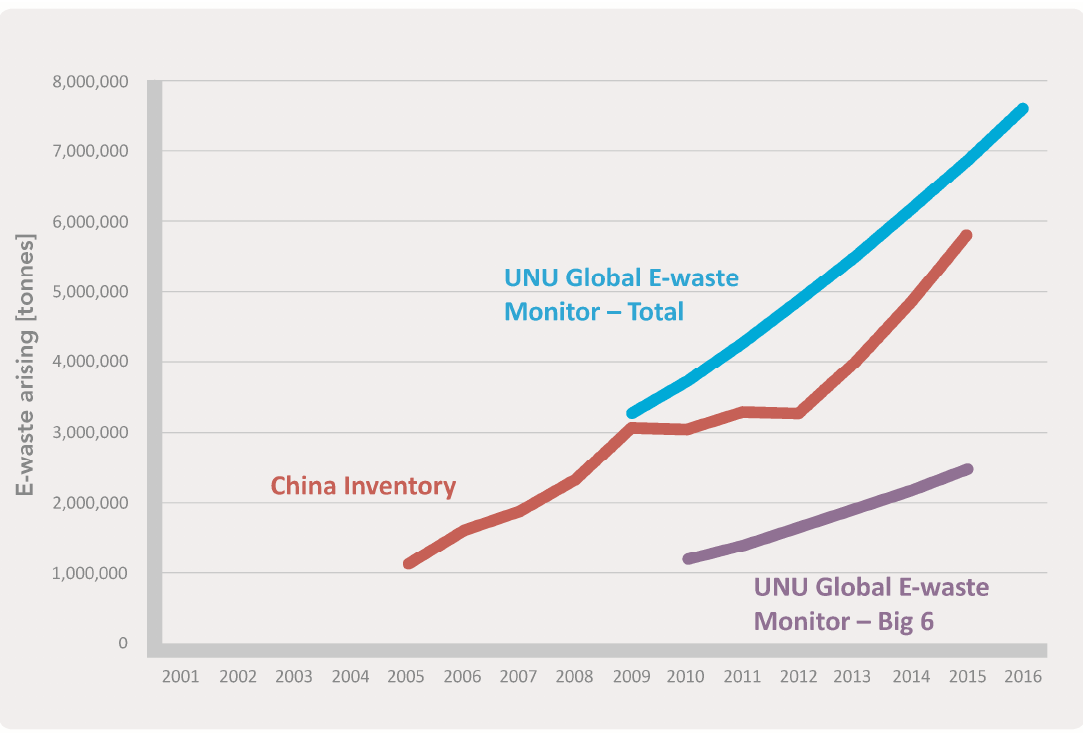
Figure 3. E-waste arising in China [31], p. 143.